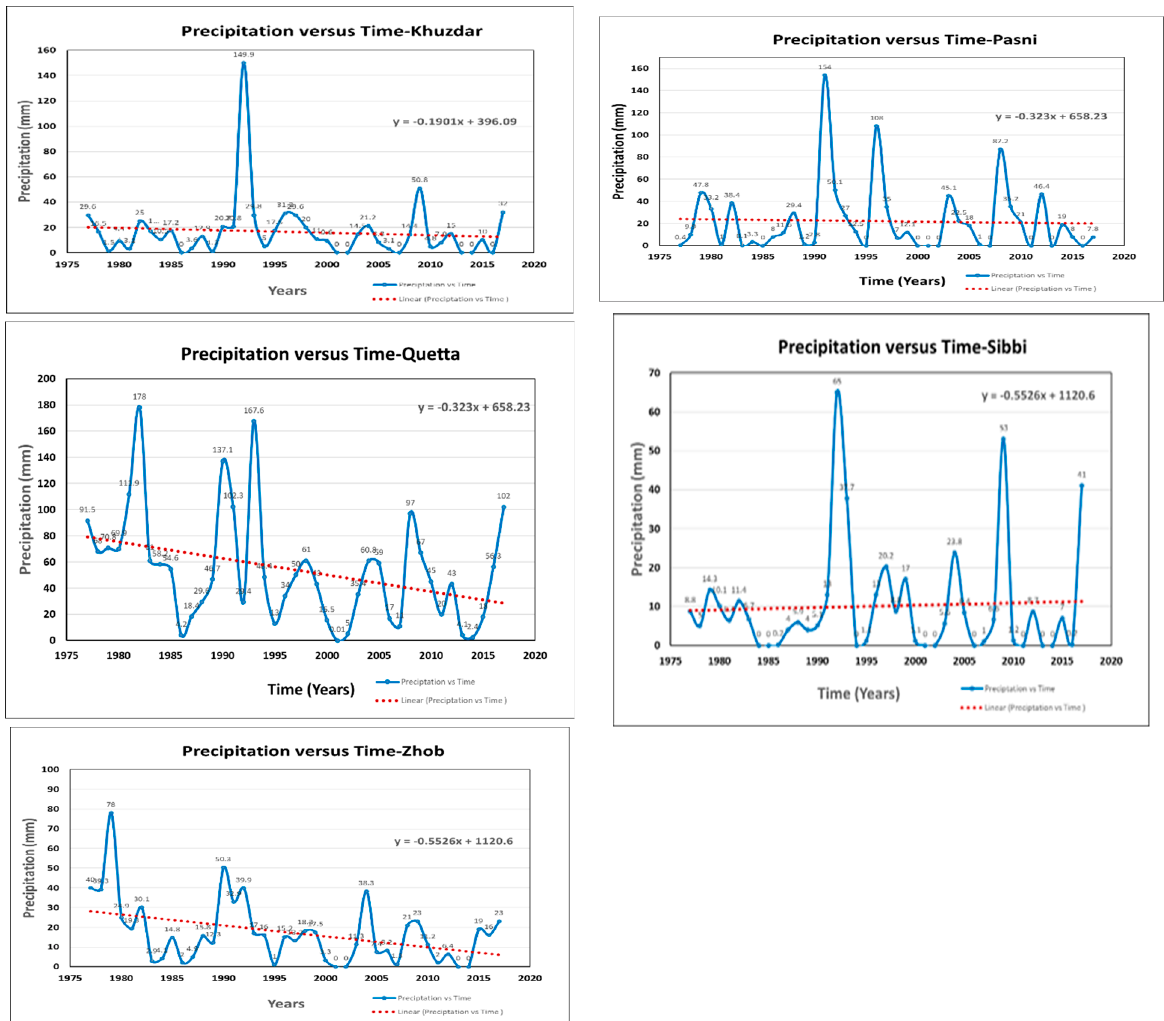
Figure A1. Graphs for January and June.